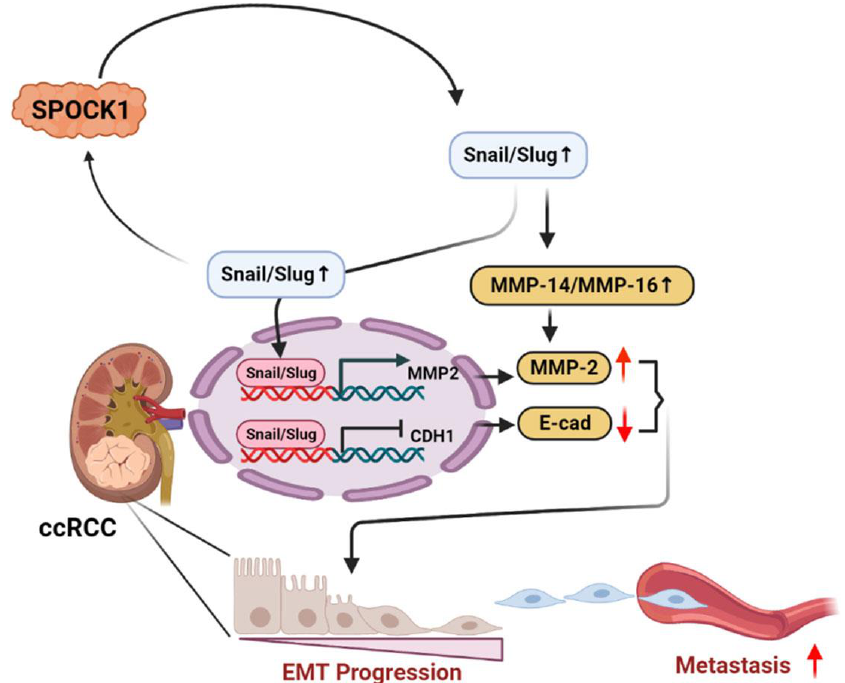
Figure 7. A working model shows the molecular mechanism underlying the ability of SPOCK1 to promote the progression of clear cell renal cell carcinoma (ccRCC) cells. The prometastatic effect of SPOCK1 on ccRCC cells was attributed to induce the upregulation of Snail family members (Snail and Slug) following transcriptional downregulation of E-cadherin and upregulation of the matrix metalloproteinase (MMP)-2. Moreover, SPOCK1-induced upregulation of Snail family members also shows the positive feedback regulation of SPOCK1. These signal pathways ultimately trigger epithelial-to-mesenchymal transition (EMT) progression and subsequent promotion of ccRCC metastasis. Green ovals indicate hypothetical regulators which might be involved in the SPOCK1-mediated interplay of Akt and Snail family members.